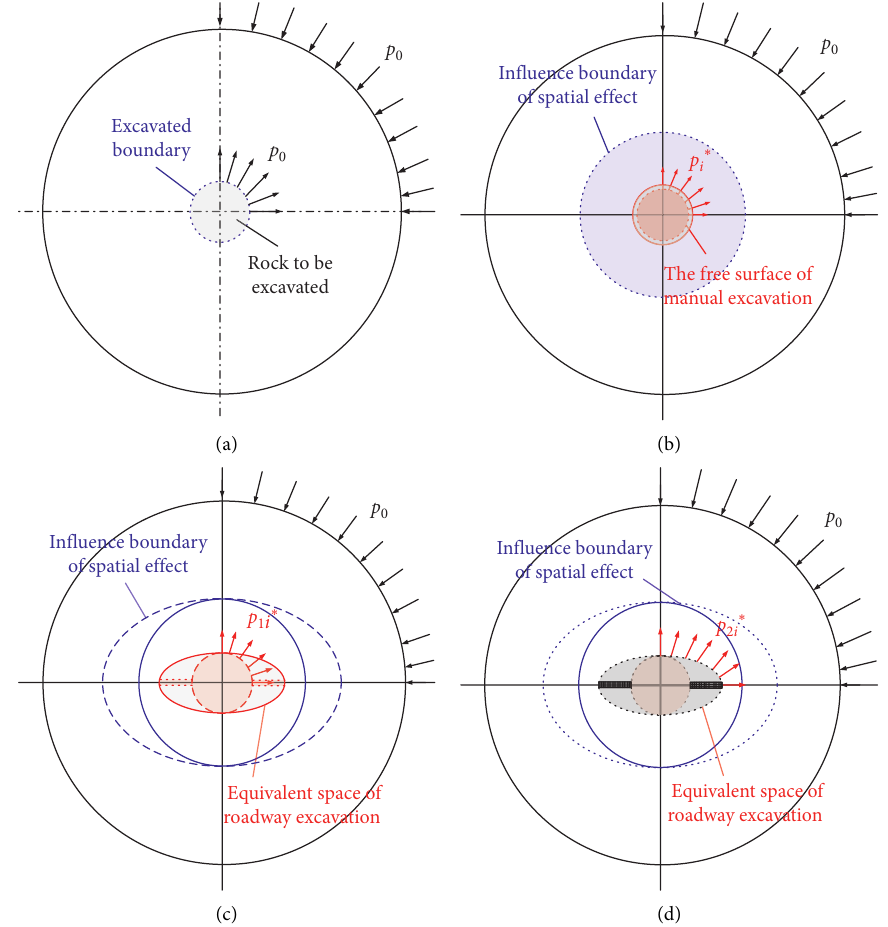
Figure 1: Stress model on bearing structure of surrounding rocks in an equivalent roadway excavation spatial effect: (a) the stress state of original rock; (b) after the roadway is dug; (c) after construction pressure-relief measures; (d) after construction reinforcement measures.